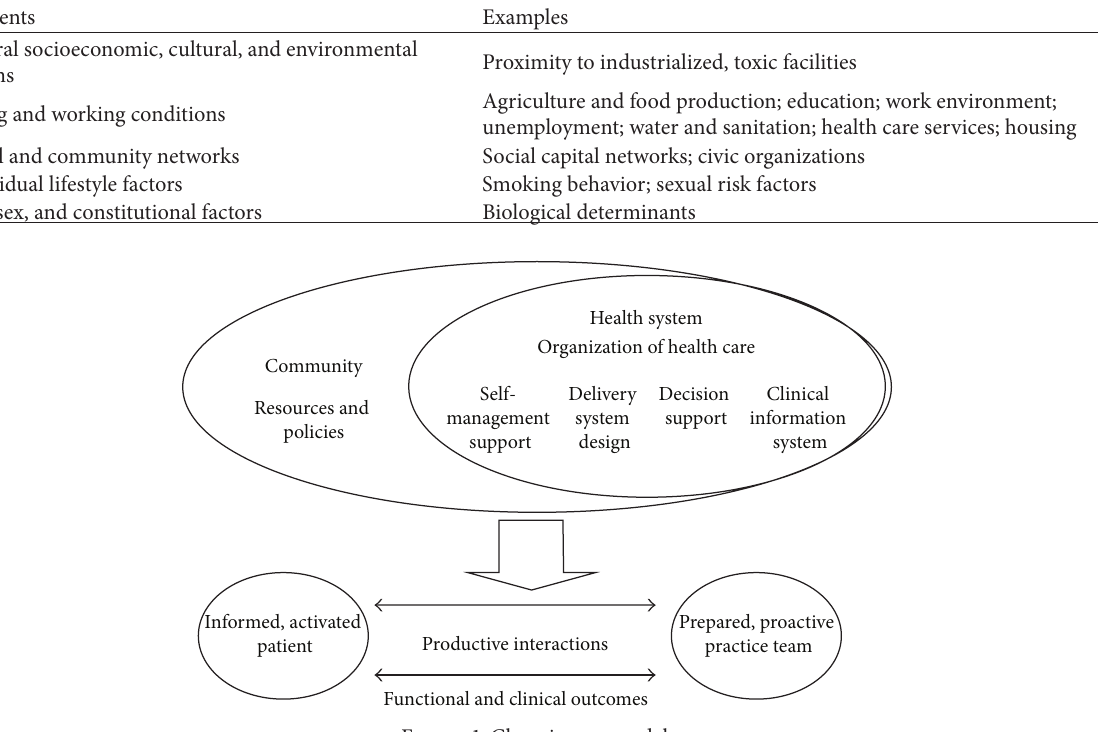
Table 1: Whitehead and Dahlgren’s social determinants of health framework components.